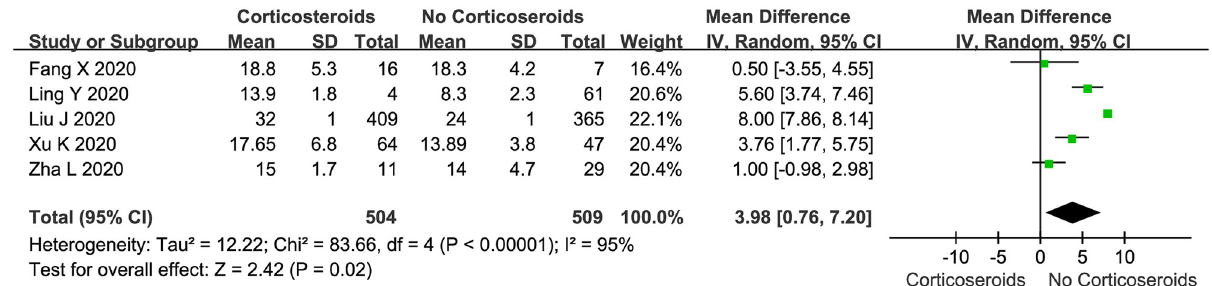
PLOS ONE | https://doi.org/10.1371/journal.pone.0249481 April 21,